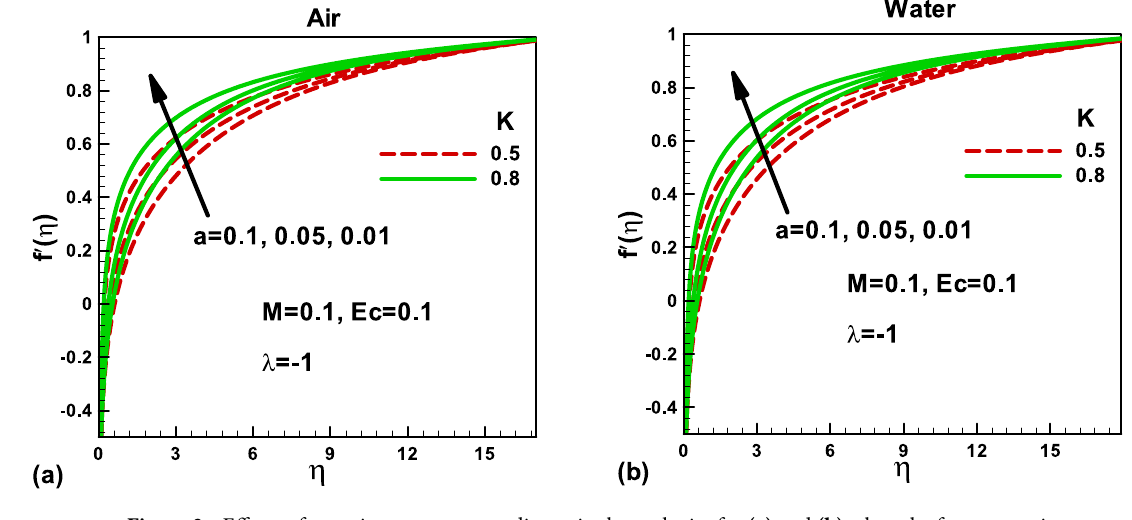
Figure 3. Effects of porosity parameter on dimensionless velocity for (a) and (b) when the free stream is moving in the positive x-axis and the needle is moving in the opposite direction.